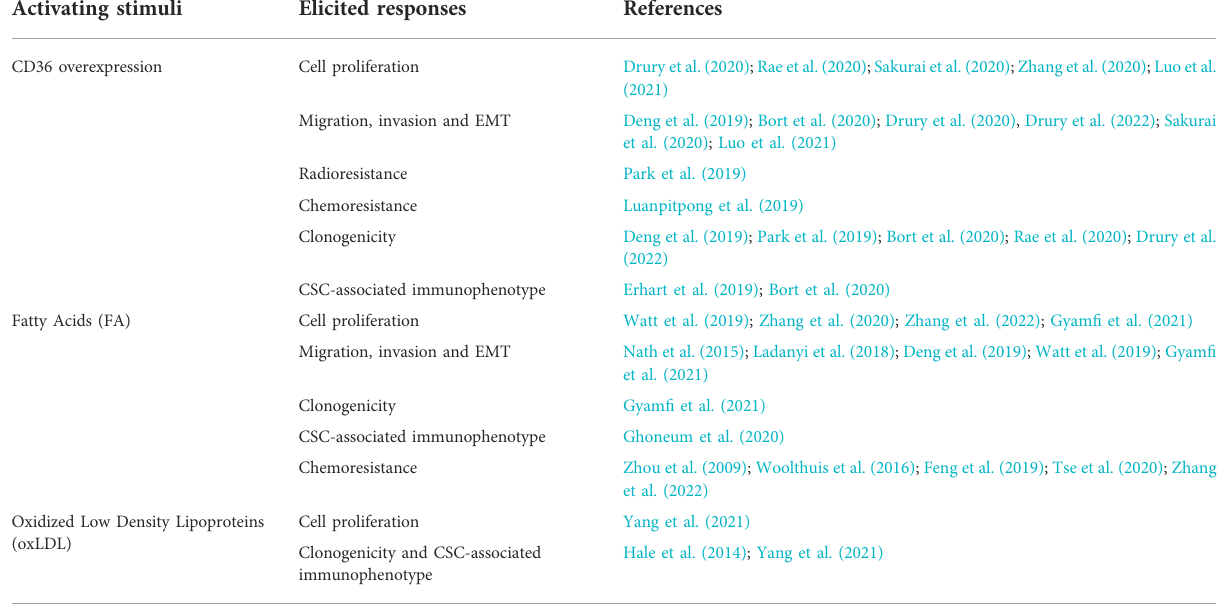
TABLE 1 Reported changes in cancer cellular functions by CD36